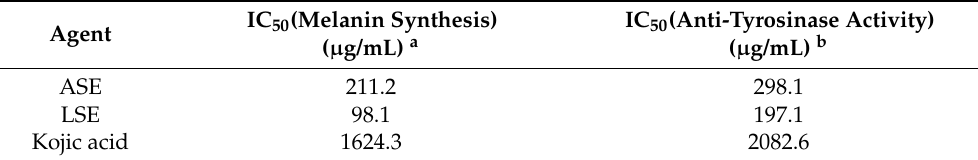
Figure 2. The ethanol extract of A. silvaticus and L. sulphureus successfully inhibited melanogenesis in zebrafish embryos without the adverse side effects on their development. Depigmenting efficacy of kojic and hydroquinone ( A ) and fungal extracts ( B ) assessed in embryos (n = 100) exposed to the different doses from 24 to 72 hpf are shown. Inhibitory effects of the tested extracts on the melanin synthesis and the tyrosinase activity at zebrafish embryos after 48 h-treatment ( C ) are shown, as well as on the melanin content in treated and untreated embryos ( D ). Statistically significant differences in the melanin content and tyrosinase activity between the control (DMSO-treated) and the treated groups (** p < 0.01; *** p < 0.001) are denoted. Table 1. Inhibitory potency of ASE, LSE, and kojic acid on the melanin synthesis and the tyrosinase activity assessed in the zebrafish embryos